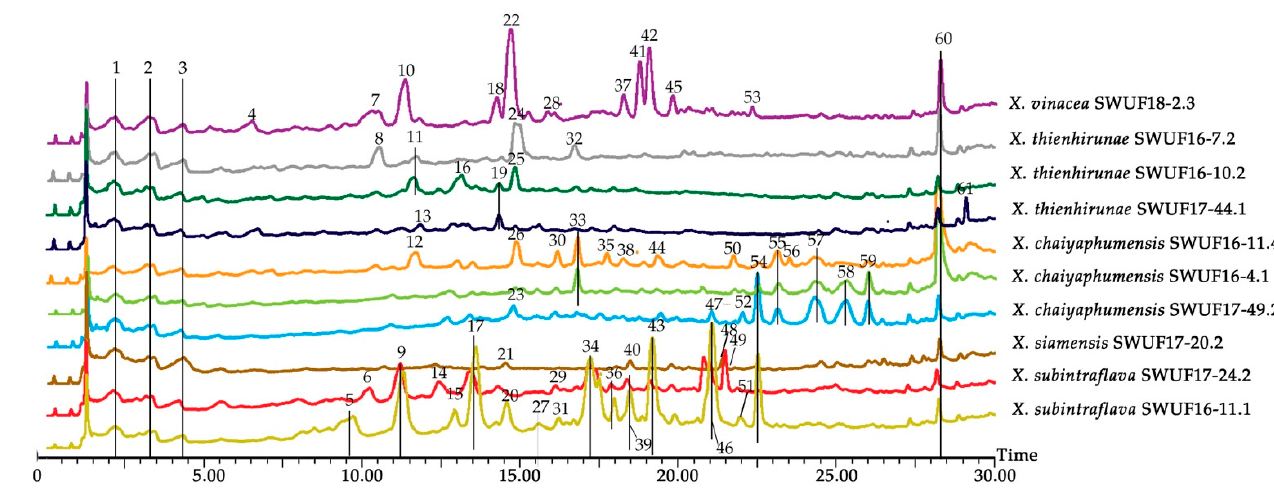
Figure 4. Total ion chromatograms (TIC) of EtOAc extracts from Xylaria culture broth. Table 1. Peak numbers and identified compounds of Xylaria EtOAc extracts obtained from database comparison. Species Isolation ID. Peak